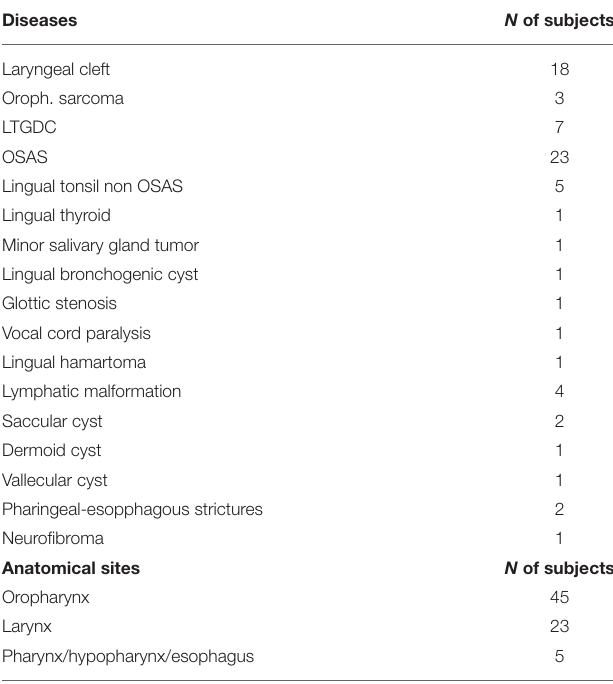
TABLE 3 | Diseases treated and anatomical localization of TORS procedures.